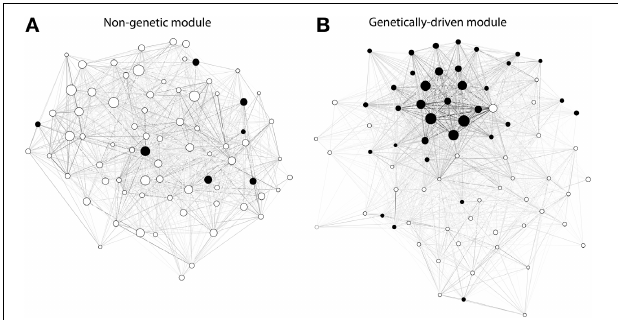
FIGURE 5 | Ilustrative examples of gene expression modules detected in the GN122 dataset from regulatory T cells (on the basis of the gene co-expression network being built using GeneNet). Each module was of equal size as they both contained a total of 75 genes; (A) : non-genetic module; (B) : genetic module. Each node is represented by a circle, either full (when the corresponding gene originates from the top contributing chromosome) or empty (other genes). The edges are colored according to a gray scale, where the darkness of the edge is proportional to the connectivity between 2 nodes. It can be seen that the genetically-driven module contains a higher number of genes from the top-contributing chromosome. Moreover, that module contains a core a several genes displaying connectivity levels that are much higher than other genes in the module, which corresponds to the fact that the values of density and centralization were higher in genetically-driven